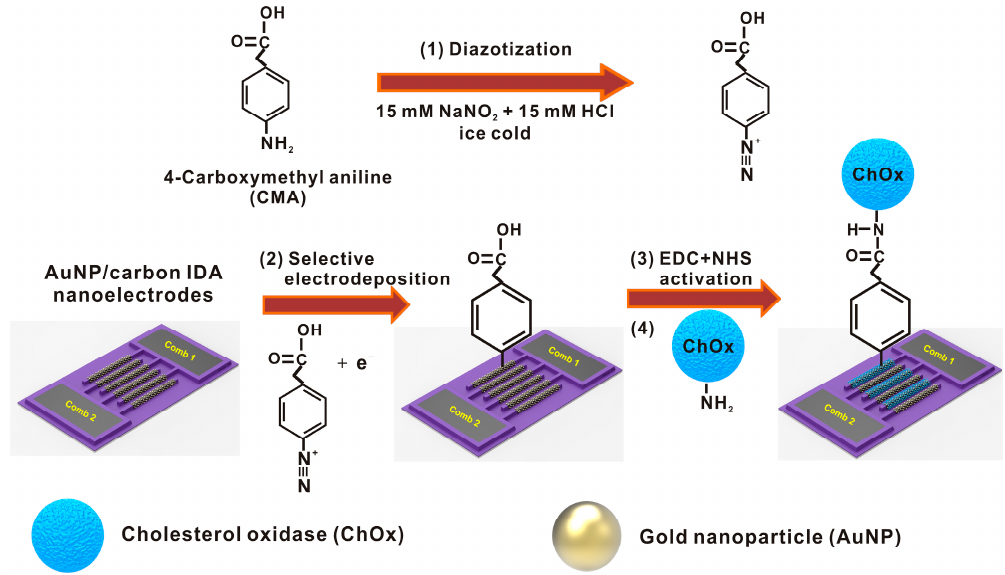
Figure 1. Steps for covalent immobilization of enzyme on the electrode surface (EDC: 1-Ethyl-3-(3-dimethylaminopropyl)-carbodiimide, NHS: N -Hydroxysuccinimide, ChOx: Cholesterol oxidase).